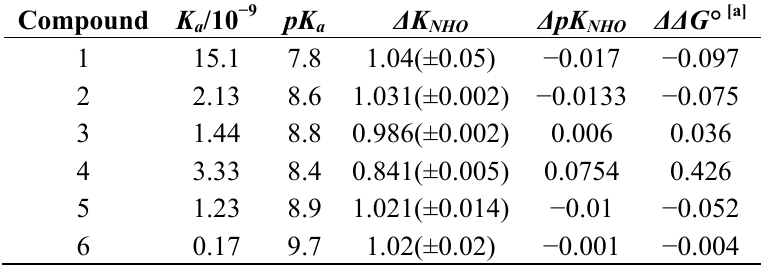
Table 1. Physicochemical parameters of compounds 1 – 6 at 296.15 ± 1 K in CD